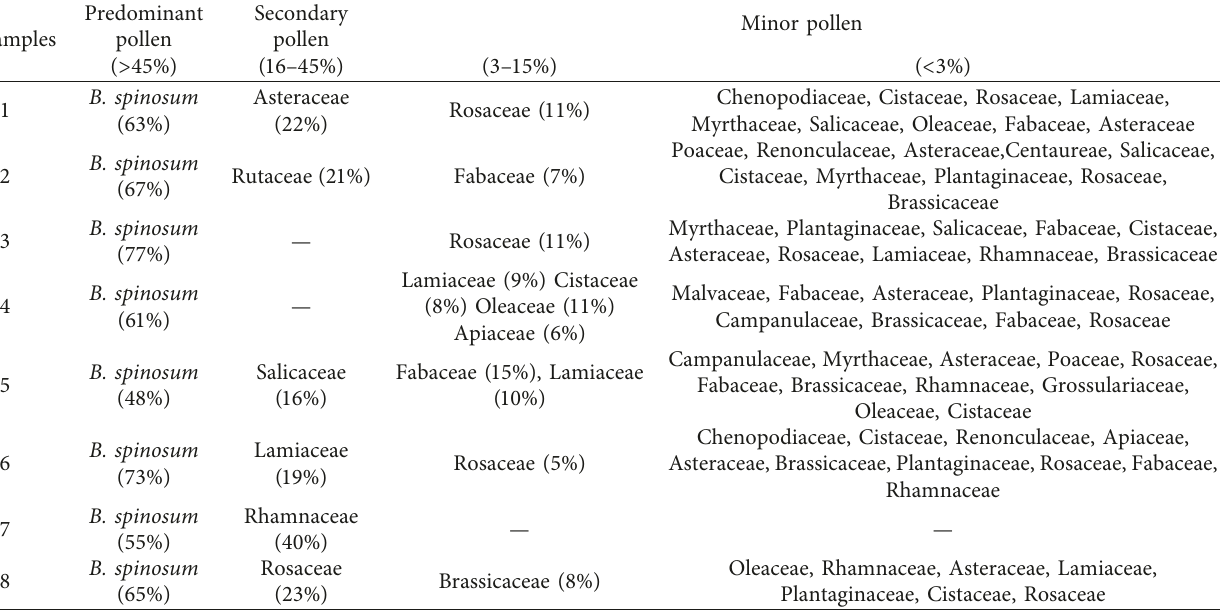
Table 2: Melissopalynological analysis of eight honey